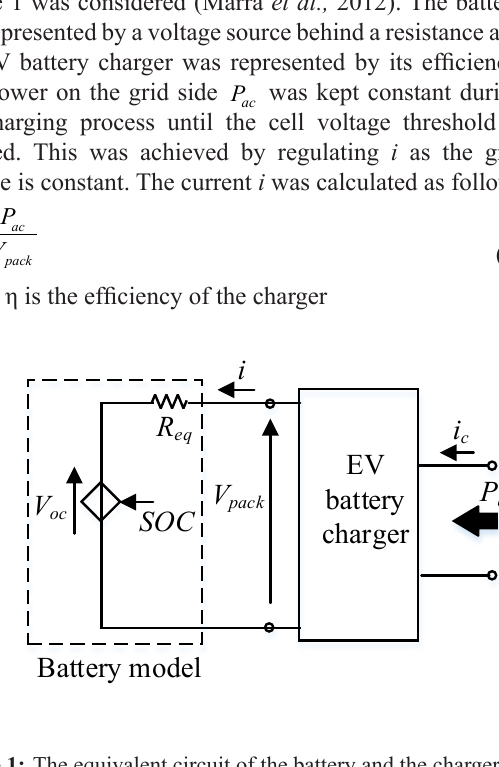
Figure 1: The equivalent circuit of the battery and the